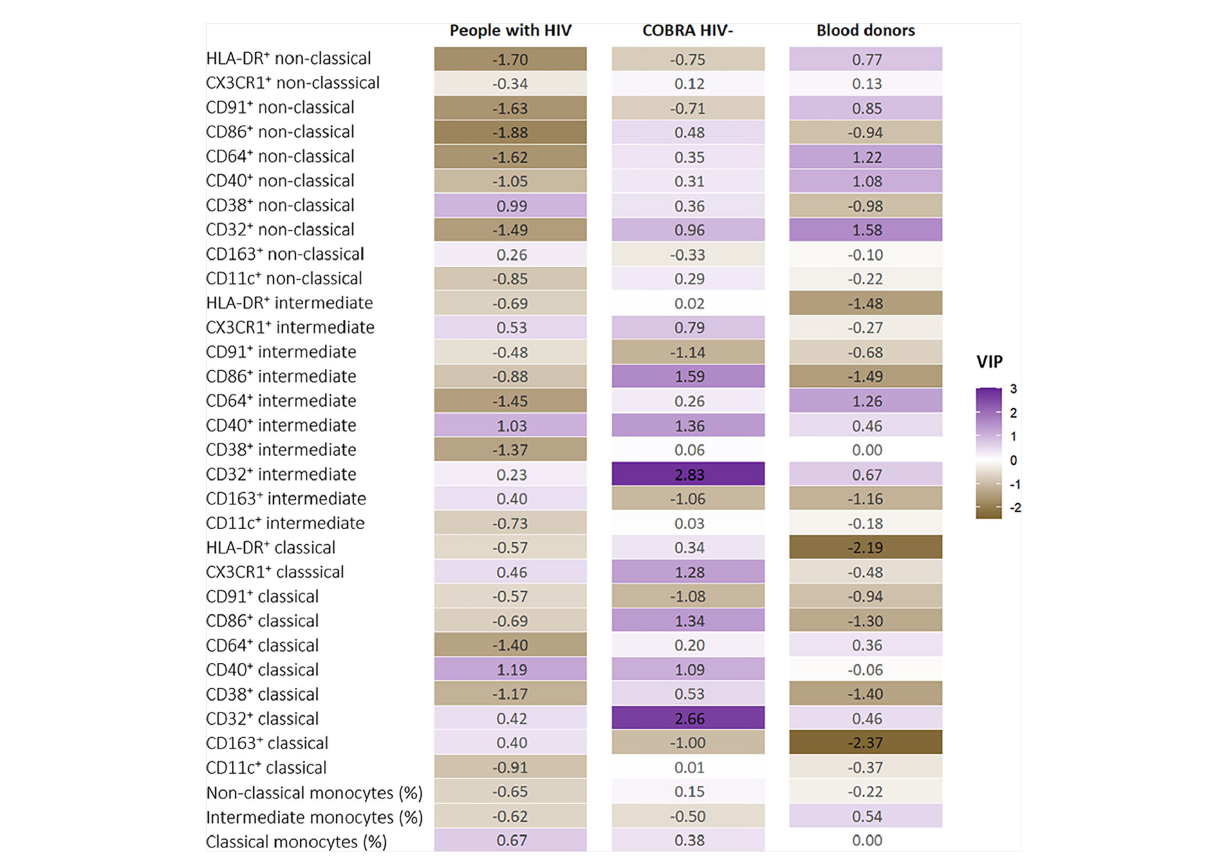
FIGURE 3 | Variable Importance in Projection (VIP) values for the monocyte markers in the partial least squares regression (PLSR) run separately in people with HIV (n=40), COBRA HIV-negative individuals (n=40) and blood donors (n=35). VIP scores are color-coded ranging from brown for a negative VIP to purple for a positive